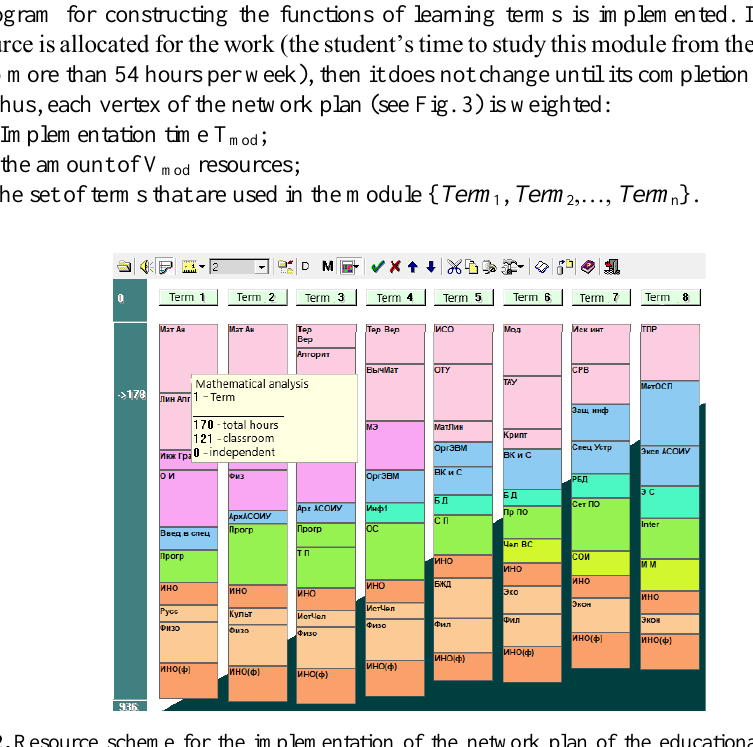
Fig. 2. Resource scheme for the implementation of the network plan of the educational process by